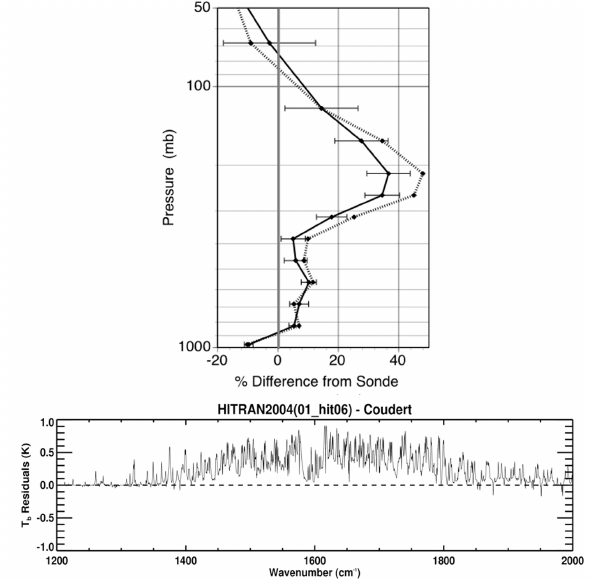
Fig. 18. Plot (a) shows the differences in the retrieved profile re- sulting from the Coudert water vapor line strengths. The dotted line is the difference from the radiosonde using the HITRAN2004 water vapor line parameters in the retrieval, and the solid line is the differ- ence from the radiosonde profile using Coudert water vapor lines in the retrieval (note the ∼ 10% difference in the upper troposphere). Plot (b) shows the model/model brightness temperature differences in the water vapor band resulting from the substitution of the HI- TRAN 2004 water vapor line strengths for the Coudert strengths for the land